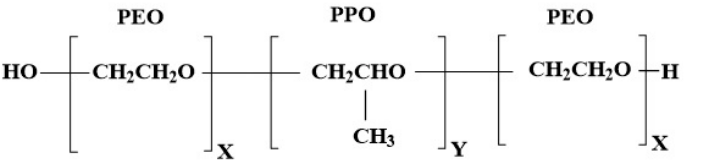
Figure 1. Representation of chemical structure of poloxamer; P407 x = 100, y = 68 and P188 x = 76, y = 29 (16).